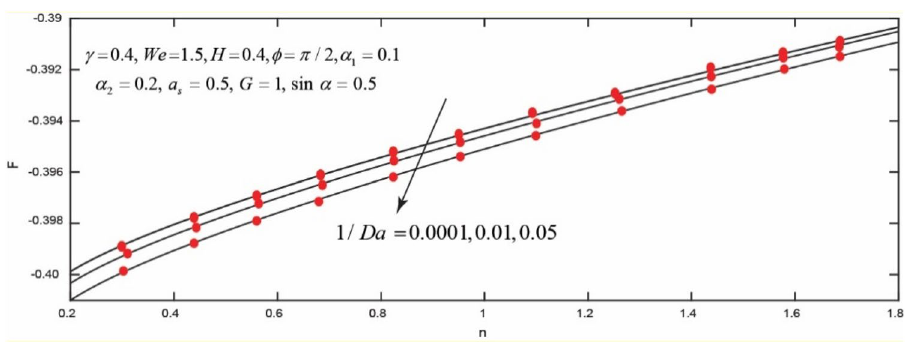
Figure 6. Impact of inclined angle Da on flow rate of swimming microorganisms.